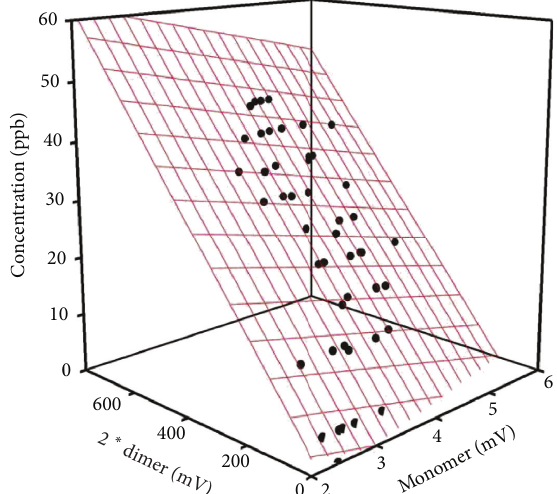
Figure 2: Acetone concentrations (ppb v ) and corresponding acetone monomer and dimer intensities (mV) measured by MCC-IMS; R 2 � 0.96. Acetone concentration (ppb v ) � 8.41–2928 ∗ acetone monomer intensity (mV)+74 ∗ acetone dimer intensity